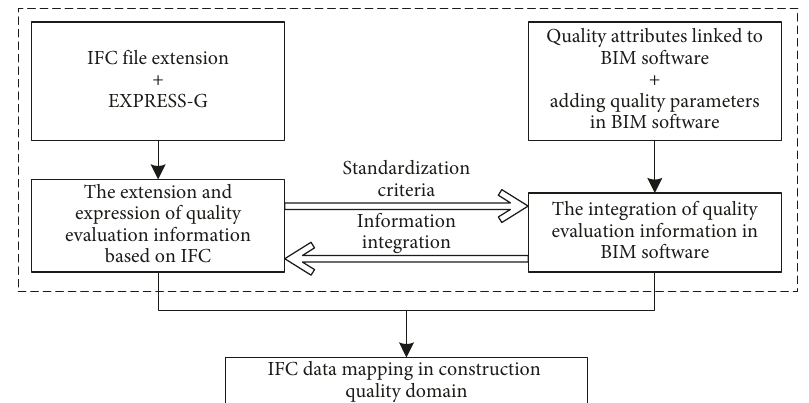
Figure 3: Implementation of IFC data mapping.